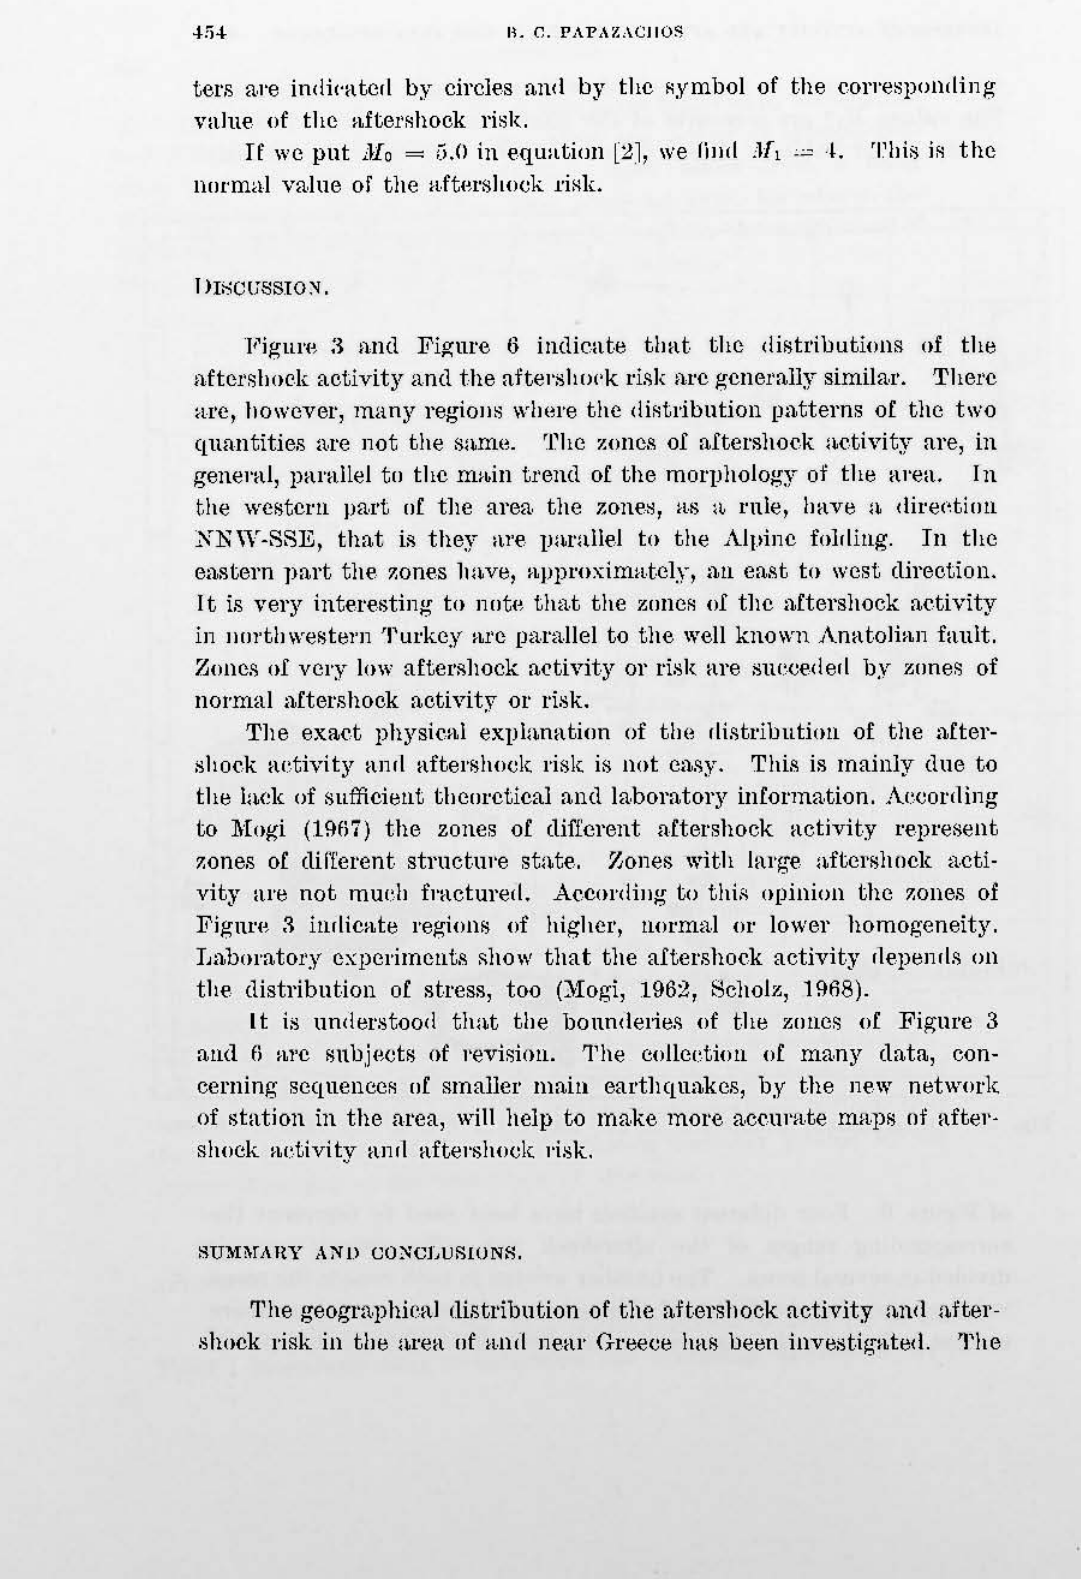
Figure :3 and Fip;ure 6 indicat.e that. the distl'ibutions oi